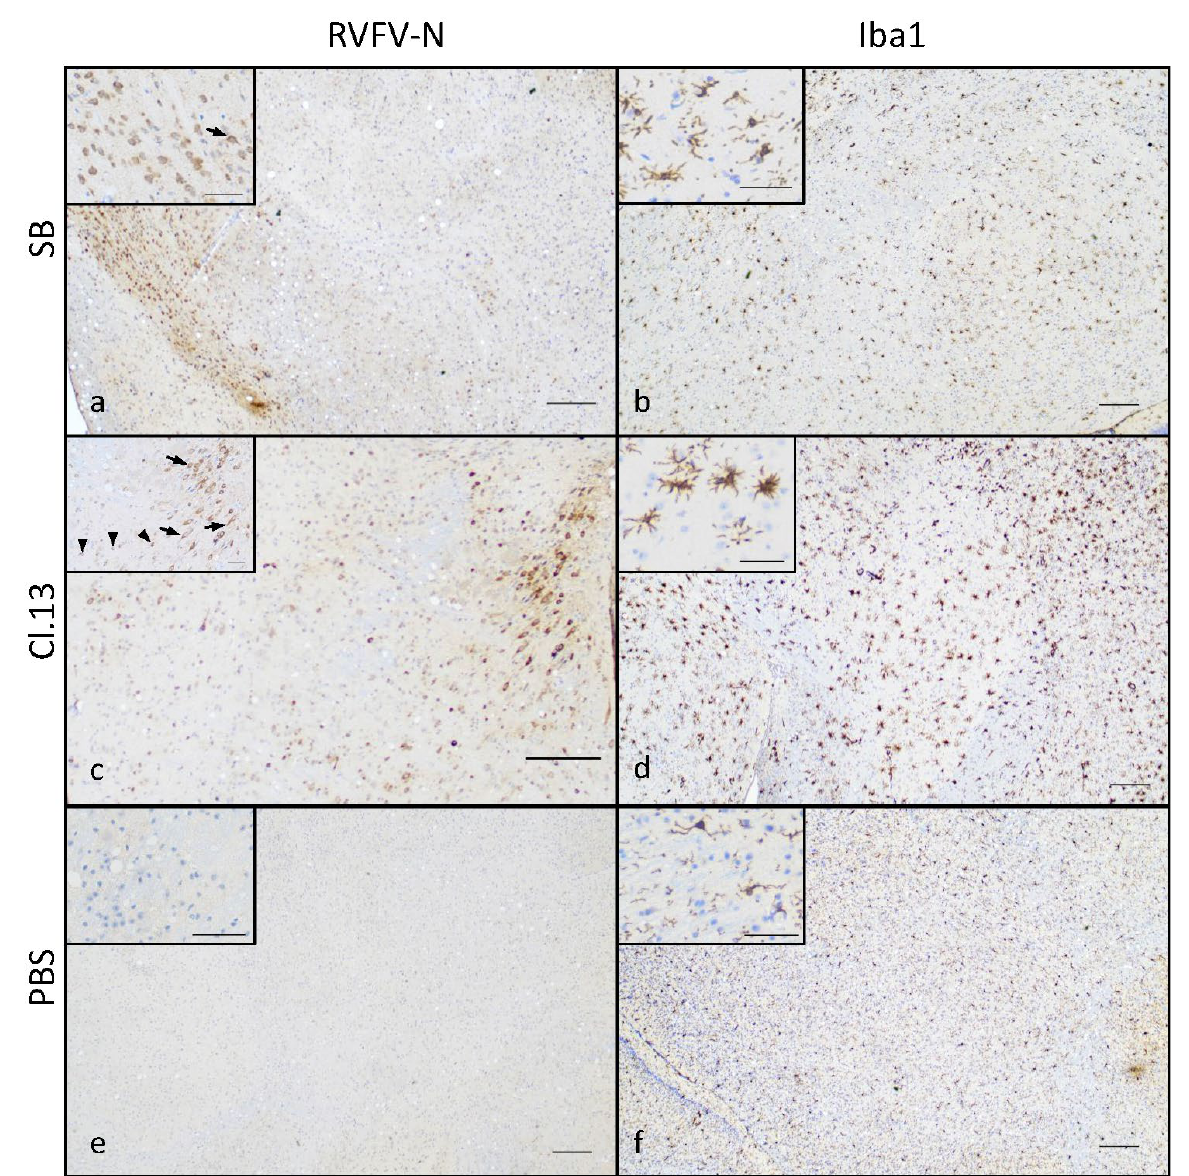
Figure 4. Brain of SB- and Cl.13-IN-infected mice displays N-protein-positive cells and activated microglia. Mice intranasally infected with the SB ( a , b ) or Cl.13 ( c , d ) RVFV strains, or inoculated with PBS ( e , f ) were euthanized at day 6–10 (Cl.13) or day 5–7 (SB) p.i. when moribund, or day 20 post-inoculation (PBS) and their brain was analyzed by immunohistochemical staining against RVFV N ( a , c , e ) and Iba1 ( b , d , f ) proteins. Representative low magnification ( × 4) images show immunoreactivity to RVFV N-protein in the cranioventral portion of the brain of SB-infected mice ( a ) and the midbrain of Cl.13-infected mice ( c ) and compared to uninfected controls ( e ). Higher magnification insets ( × 20) show cells with morphological features of neurons (arrows) and glial cells (arrowheads). Microglial reactivity assessed by Iba1 staining was mild in SB-infected mice ( b ) and more pronounced in Cl.13-infected mice with activated microglial cells (( d ), inset). Bars: 200 µ in low magnification images and 50 µ in high magnification insets.